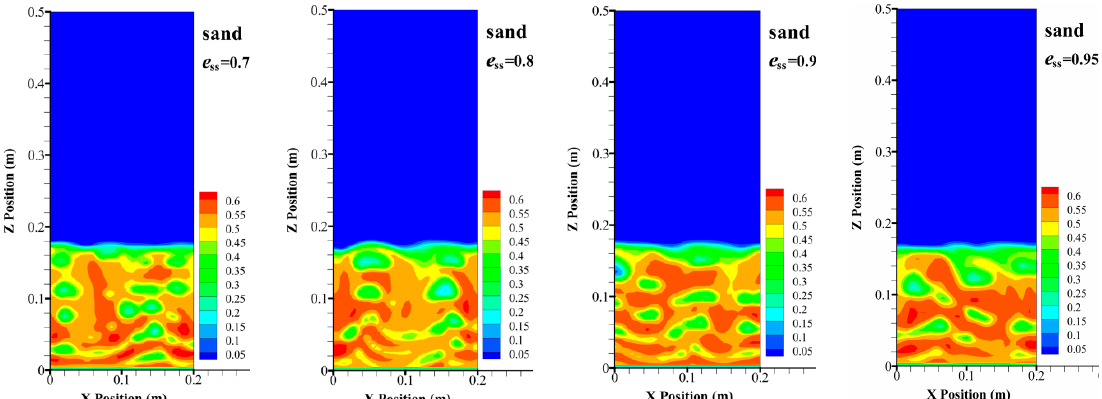
Figure 13. Distributions of instantaneous volume fraction of sand particles.